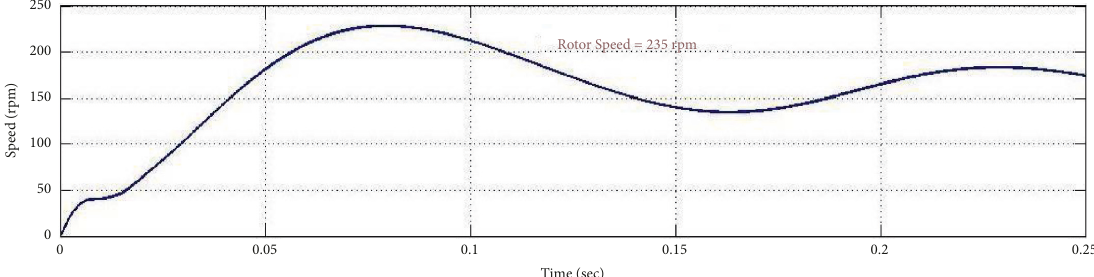
Figure 13: Rotor speed response.